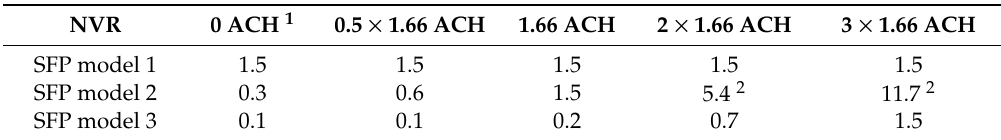
Table 9. The SFP values of ventilation unit’s fans (supply and return fans) for di ff erent NV rates in three various models (kW / (m 3 /